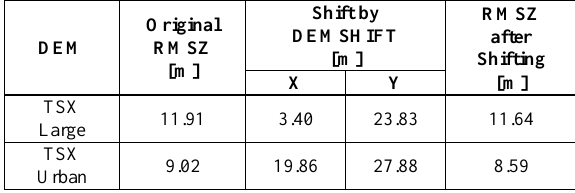
Table 1. Adjusted shifts between TSX DEM and REFDTM